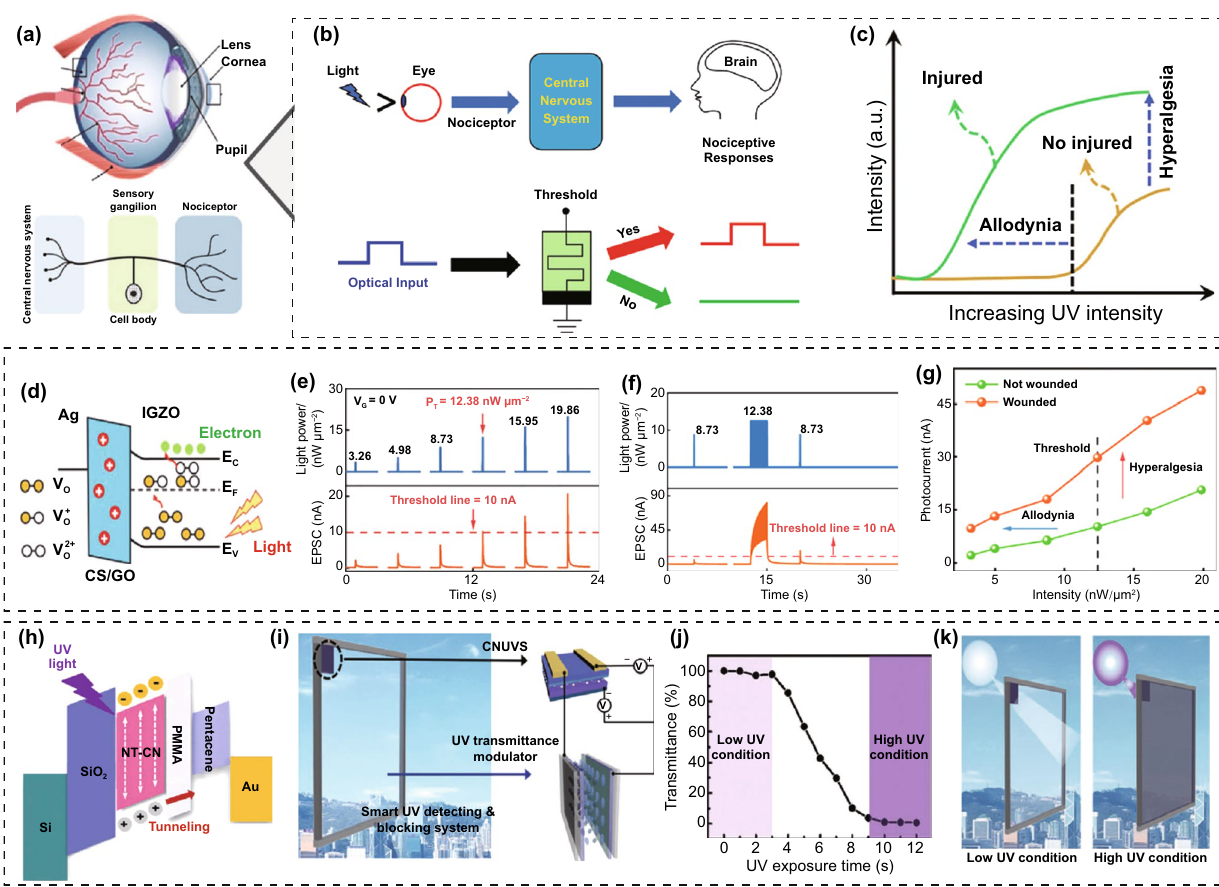
Fig. 14 Neuromorphic Nociceptive Sensor. a biological and b biomimetic nociceptive sensing system and c schematic characterization of noci‑ ceptive allodynia and hyperalgesia behaviors. d – g Metal oxide‑based photonic nociceptor: d energy band structure and working mechanism, e light intensity‑dependent threshold behavior, f threshold behavior depending on combination of the stimulus condition (intensity and pulse num‑ ber), and g the allodynia and hyperalgesia characteristics. h – k Smart system using a neuromorphic photosensor and a transmittance modulator for UV protection: h energy band structure and working mechanism, i UV‑light‑blocking smart window system j UV transmittance of the system as a function of UV exposure time, and k schematic proof‑of‑concept of the system. a Reproduced with permission from Ref. [109]. Copyright @ 2020, Springer Nature. b , c Reproduced with permission from Ref. [118]. Copyright @ 2019, Wiley‑VCH. d – g Reproduced with permission from Ref. [119]. Copyright @ 2021, Wiley‑VCH. h – k Reproduced with permission from Ref. [120]. Copyright @ 2020,